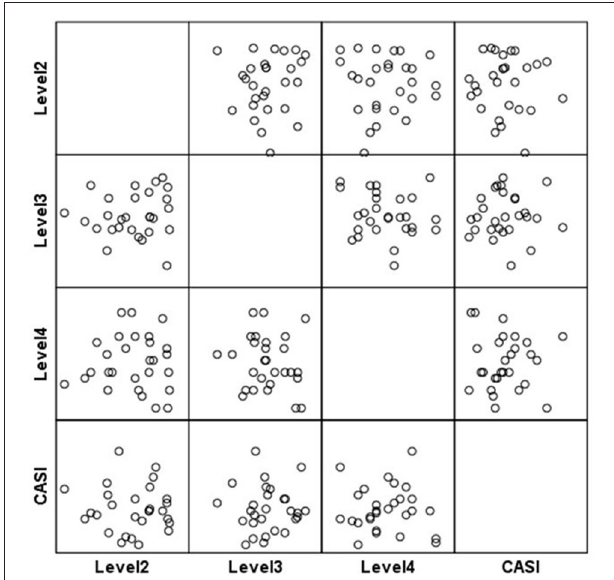
FIGURE 3 | Scatterplot matrix for Level 2, 3 and 4 scores.